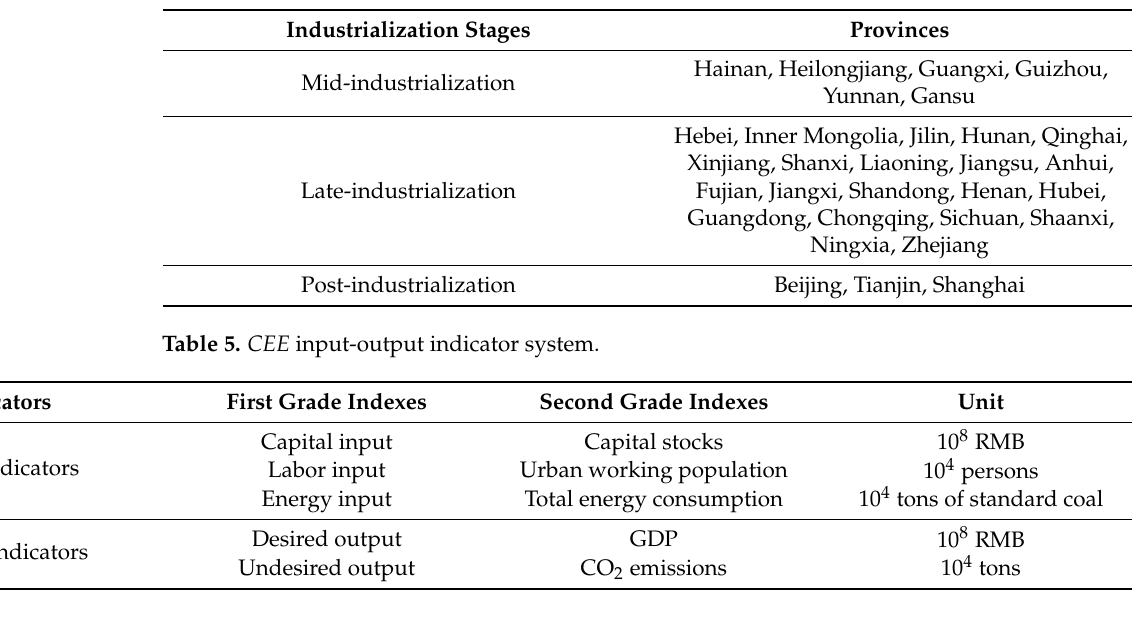
Table 4. Division of industrialization stages in 2020.